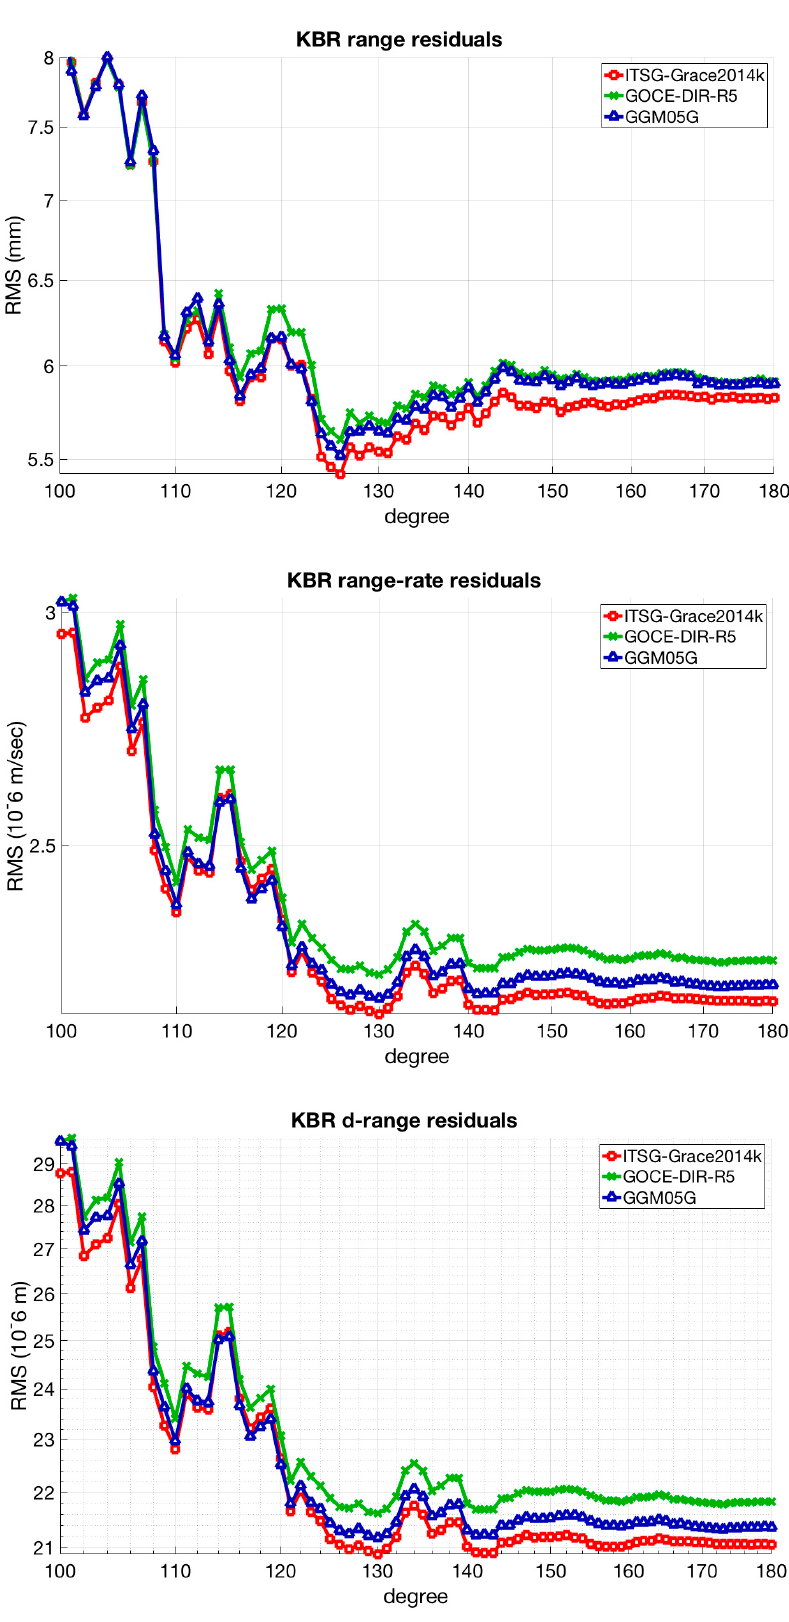
Figure 3. RMS variances of K-band ranging (KBR) data residuals to the Gravity Field and Steady-State Ocean Circulation (GRACE) estimated orbits based on static gravity field models. The term d-range refers to the approach of eliminating the KBR range bias based on sequential range differences.